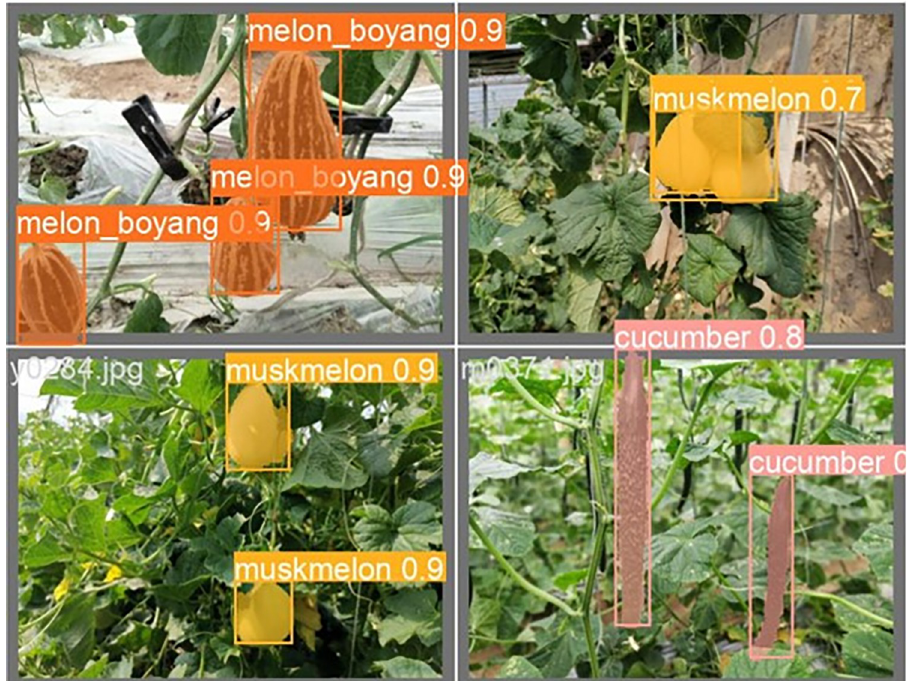
Fig 18. Image results of